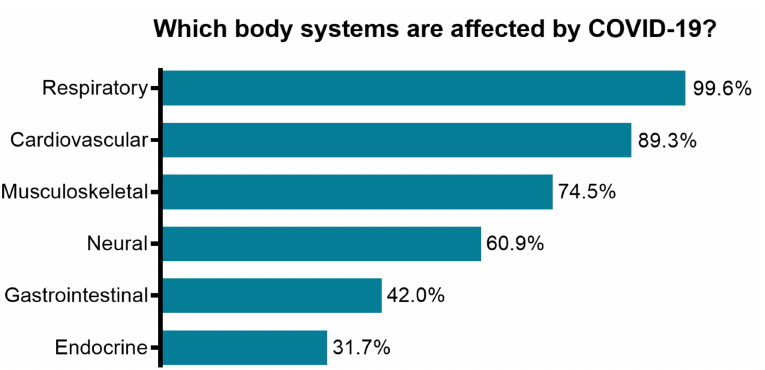
Figure 1. Current perception of survey participants on the potential impairment of body systems caused by COVID-19